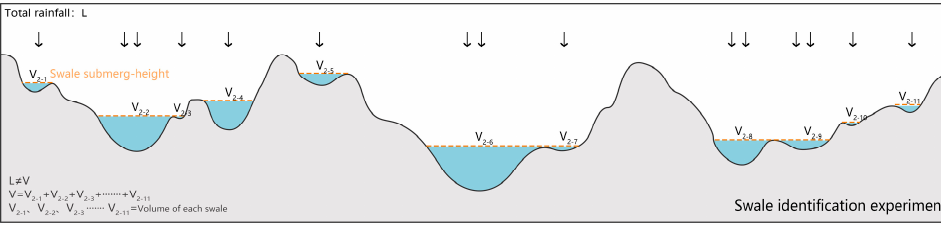
Figure 2. Swale identification experiment.